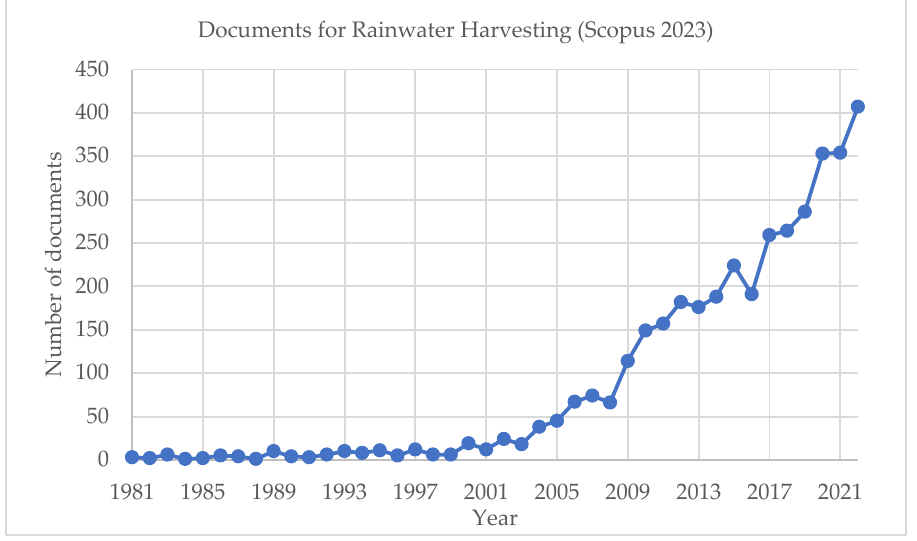
Figure 1. Number of documents in Scopus (6 February 2023) corresponding to the keyword “rainwater harvesting”.